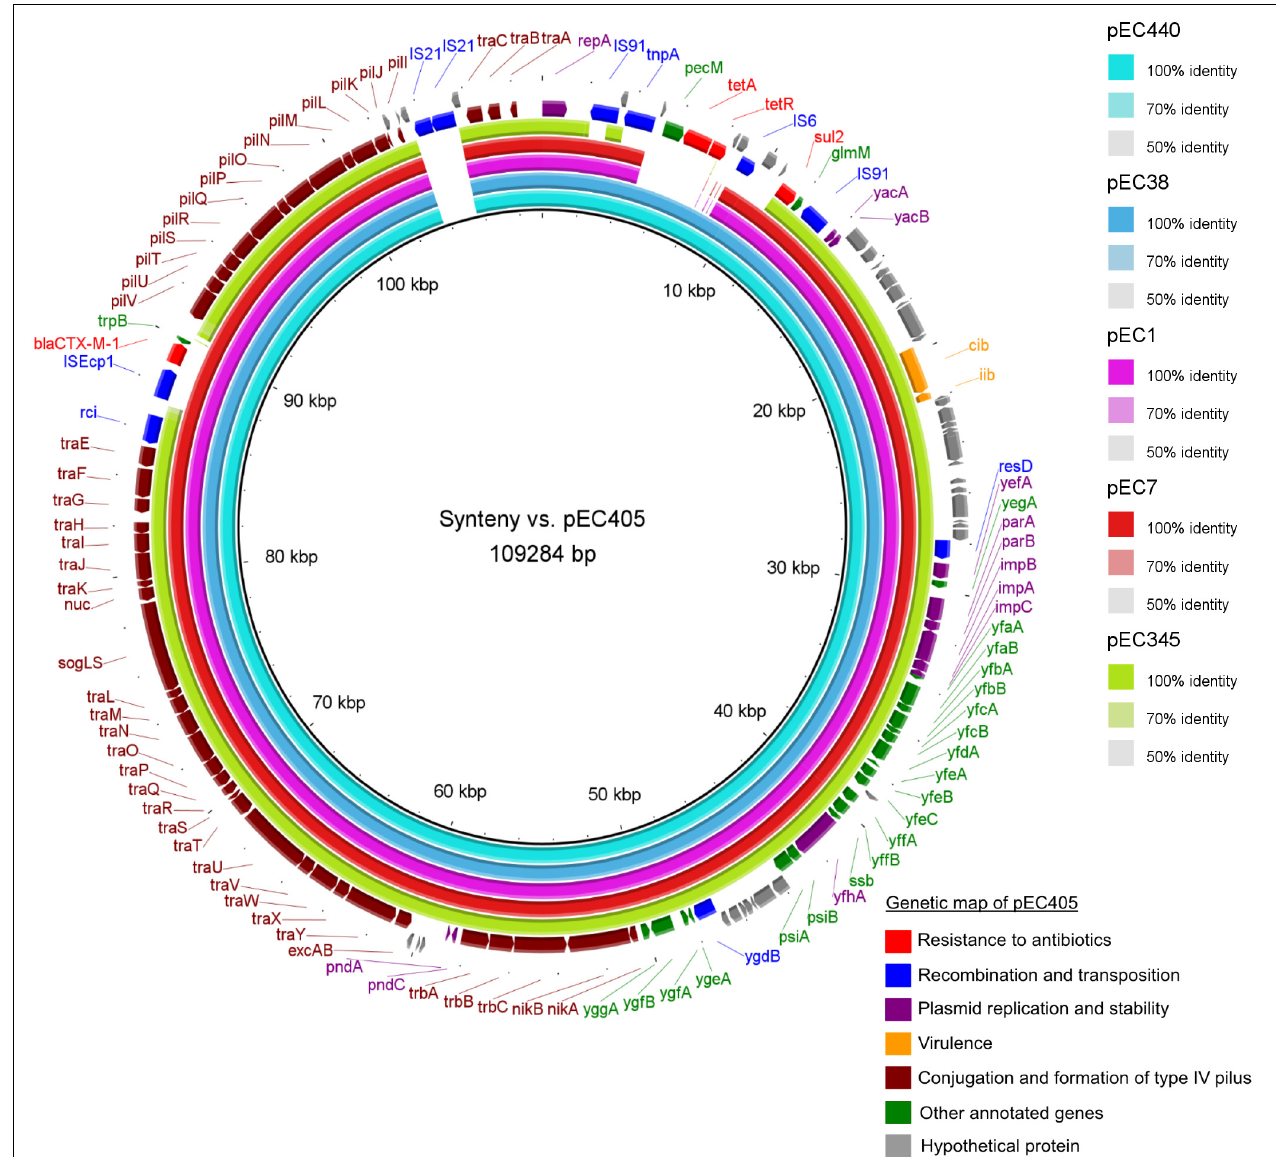
FIGURE 2 | Genetic organization of accessory region carrying antibiotic resistance genes among IncI1-I γ /ST3 plasmids from six Escherichia coli isolates collected in Guadeloupe (reference pEC405, 1 to 12,177 bp).